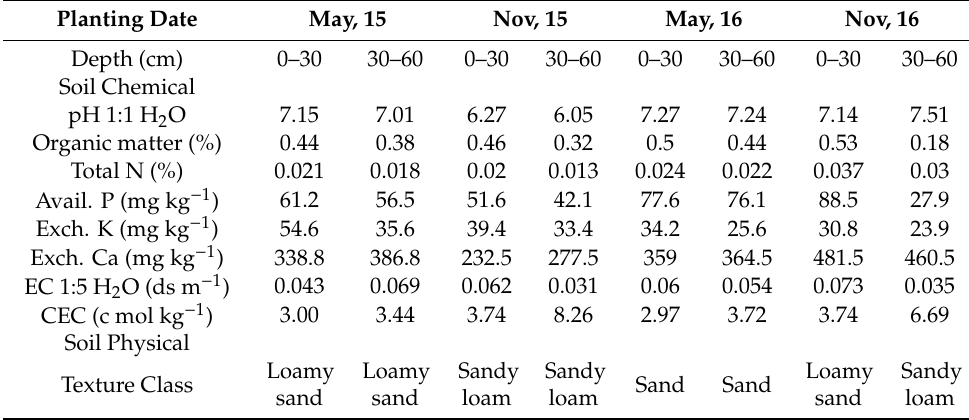
EC, electrical conductivity; CEC, cation exchange capacity.